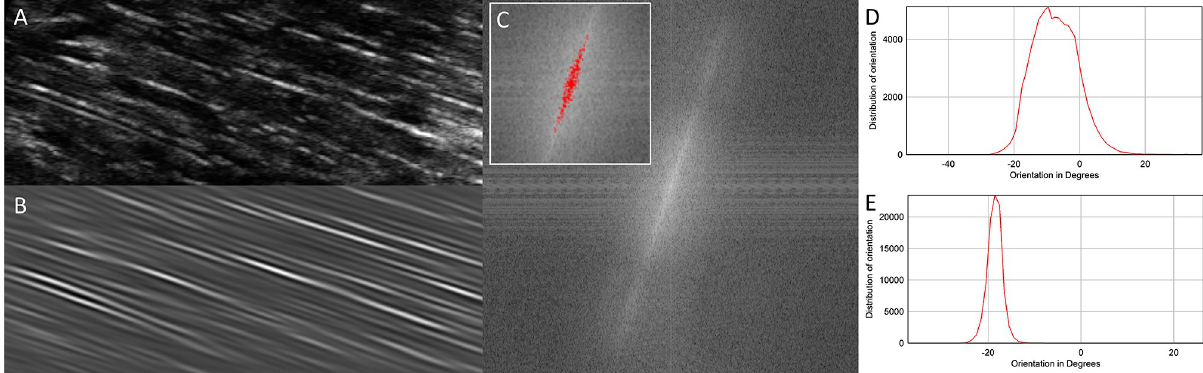
Fig 3. Example of raw (A) and processed (B) images of fascicles. Processing amplifies the signal of structures aligned with the direction of the fascicles by thresholding of the power spectrum (C). The resulting distribution of orientation computed with the OrientationJ plugin is narrower for the processed image (E) than for the original one